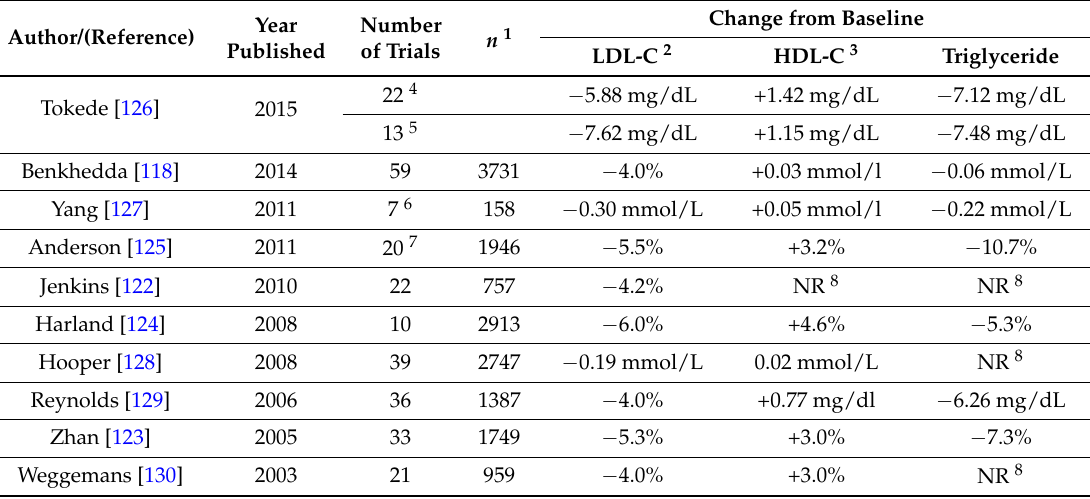
Table 3. Meta-analysis of clinical studies evaluating the effects of soy protein on lipid